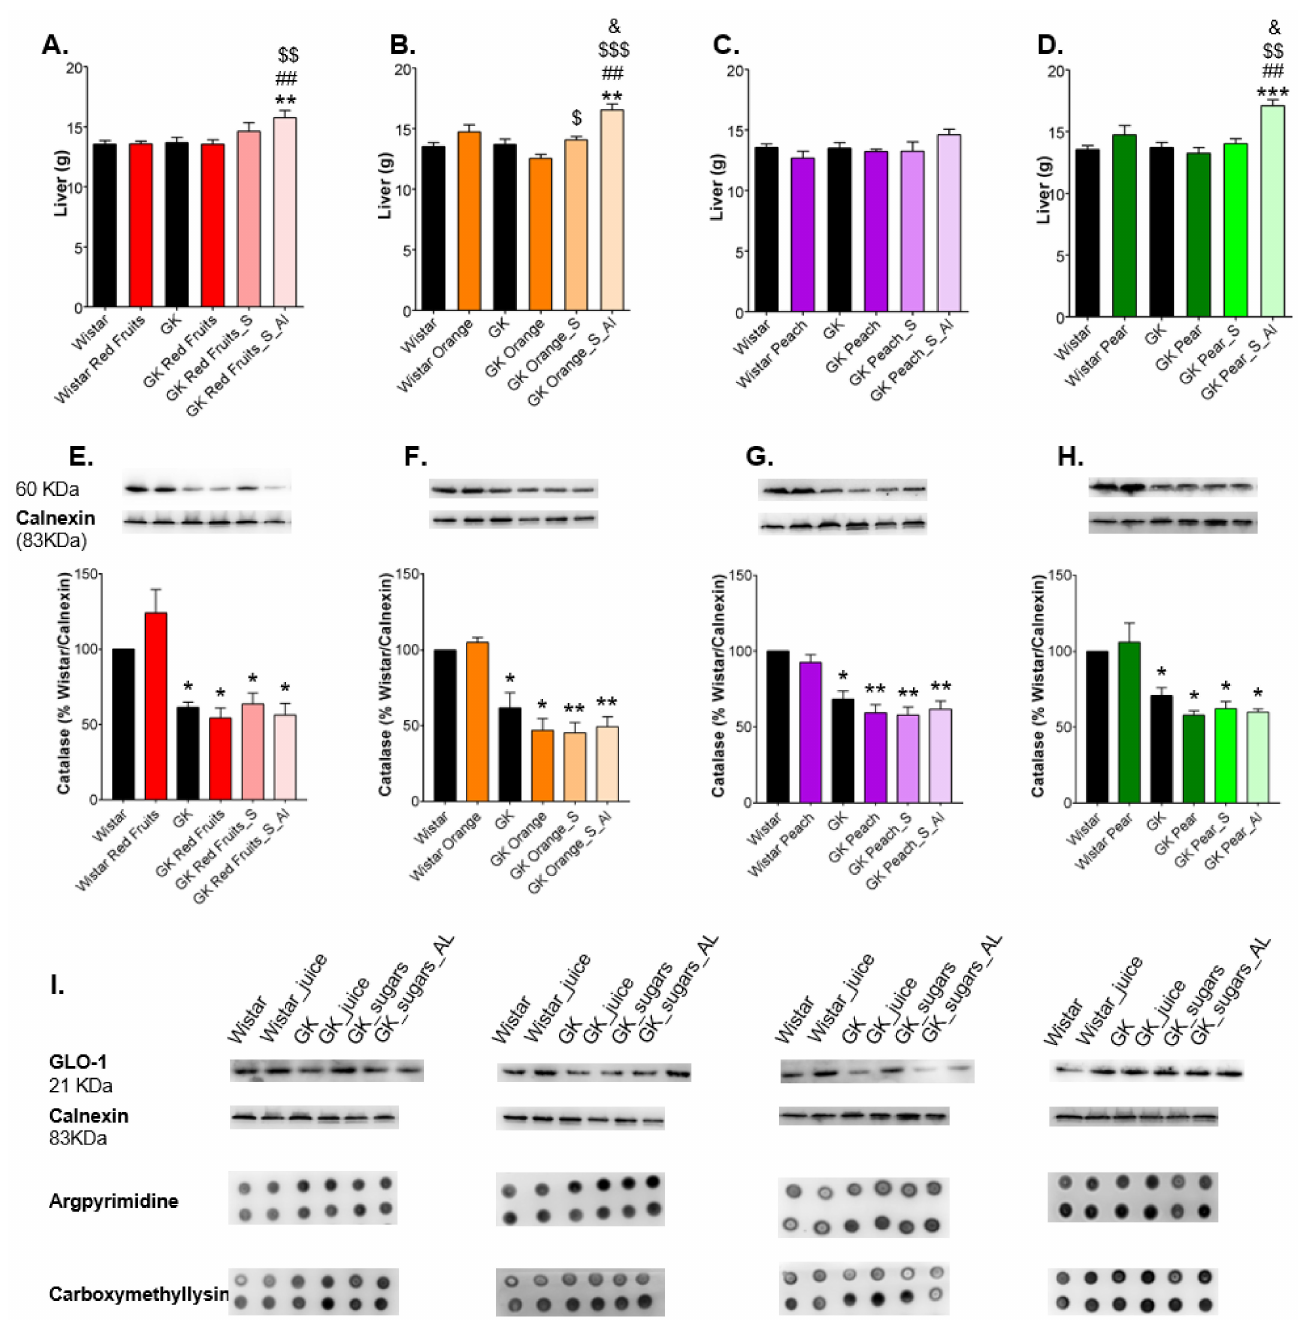
Figure 5. Liver weight was recorded ( A – D ) and the levels of catalase were determined by Western Blot ( E – H ). Representative western blot membranes of GLO-1 and dot blot membranes of CML and argpyrimidine in the liver are shown in ( I ). * different from Wistar; # different from GK; $ different from GK_Juice; & different from GK_S. 1 symbol, p < 0.05; 2 symbols, p < 0.01; 3 symbols, p <